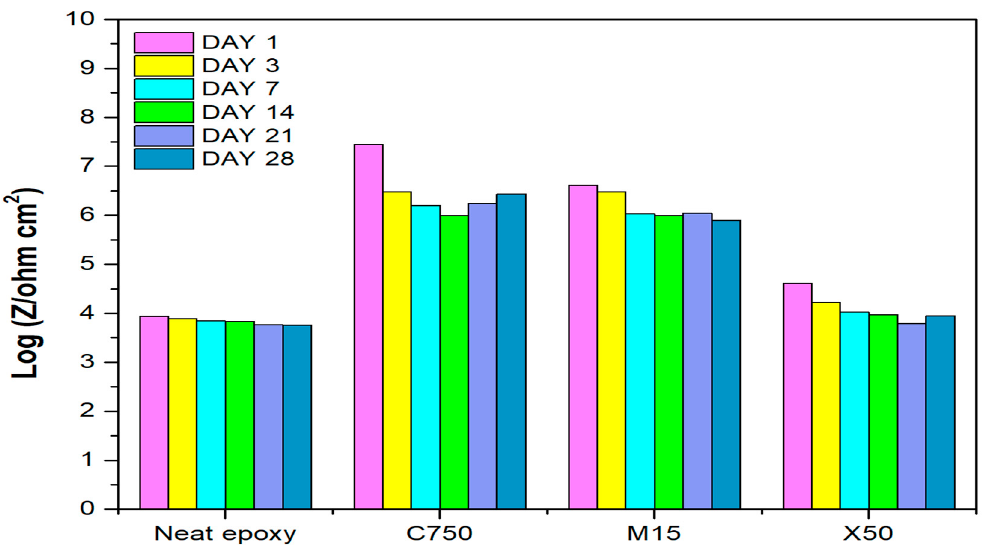
Figure 10. Impedance values at low Frequency end (10 mHz) of prepared Gnp/epoxy composite coatings immersed in 3.5% NaCl solution at different Time.